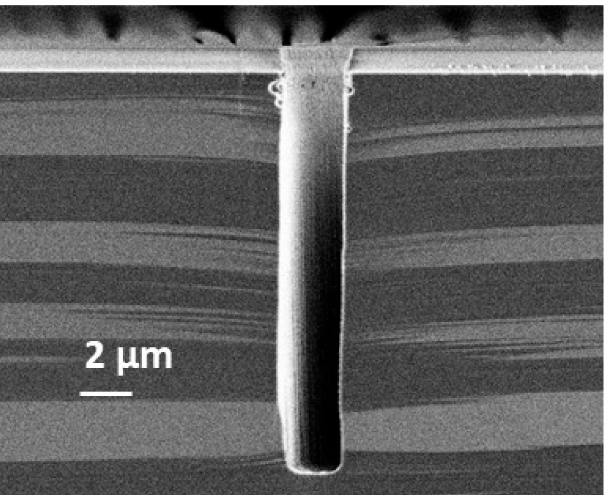
Figure 5. Cross section view of 2 µ m wide trenches etched at − 50 ◦ C with STiGer process—2 s pas-sivation (70 sccm SiF 4 , 70 sccm O 2 , 1500 W source, 15 V bias, 1.1 Pa), 1.5 s etch (150 sccm SF 6 , 1500 W source, 90 V bias, 1.9 Pa), ~171 cycles, T = − 50 ◦ C, Alcatel 601E ICP